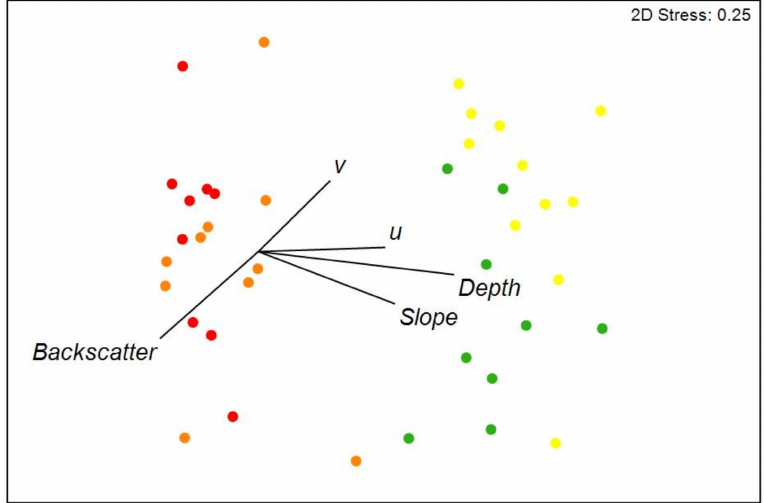
Figure 3. Results of the composed Multidimensional Scaling (MDS) showing the ordination of beam trawl samples according to environmental variables analyzed (depth, slope, and backscatter of the seabed and horizontal (u) and vertical (v) components of bottom currents). Samples from Non-impacted, Low effort history, Medium effort history, and High effort areas are in green, yellow, orange, and red,